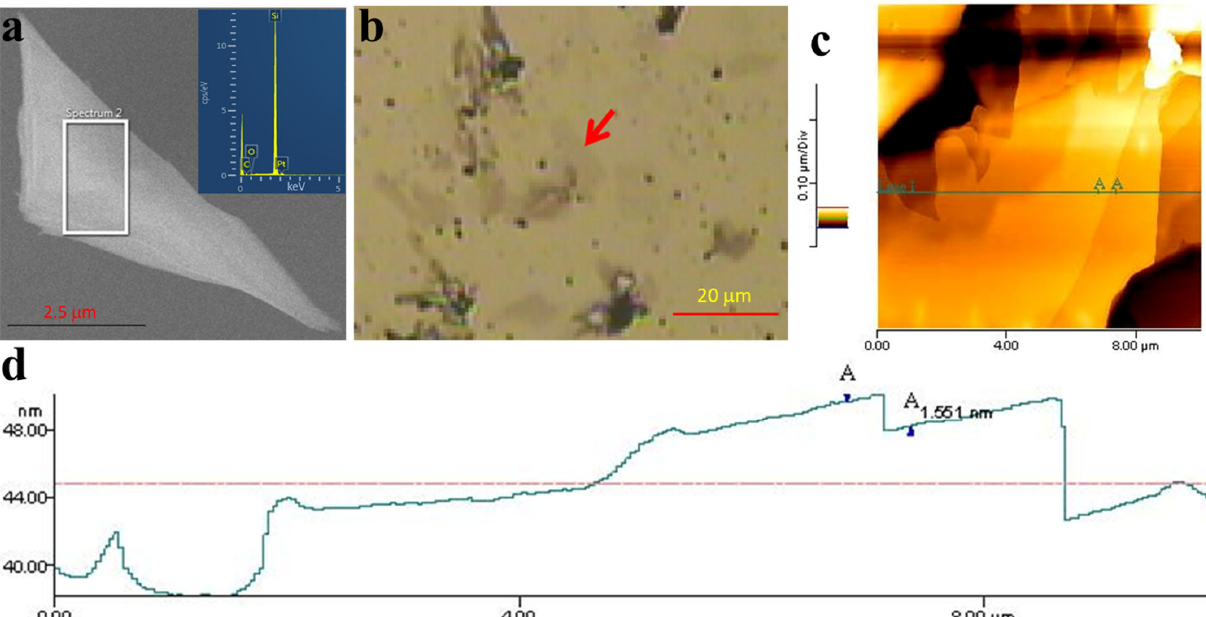
Figure 4. Dimension and thickness analysis of the 2D crystal of Pt. ( a ) The FESEM image of the 2D crystal of Pt and its elemental analysis result (inset). ( b ) The confocal microscope image of the 2D crystal of Pt on the substrate surface. The red arrow in ( b ) shows the ultra-thin Pt nanosheet structure. The red arrow also indicates the position used for AFM analysis results. ( c , d ) are the AFM image and the line profile analysis result of the 2D crystal of Pt. The sample was dispersed on the Si substrate.